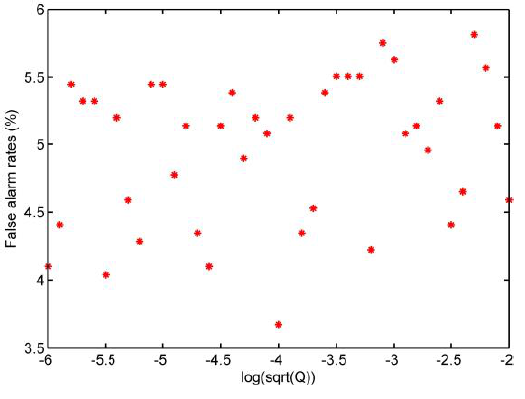
Figure 8. False alarm rates test.